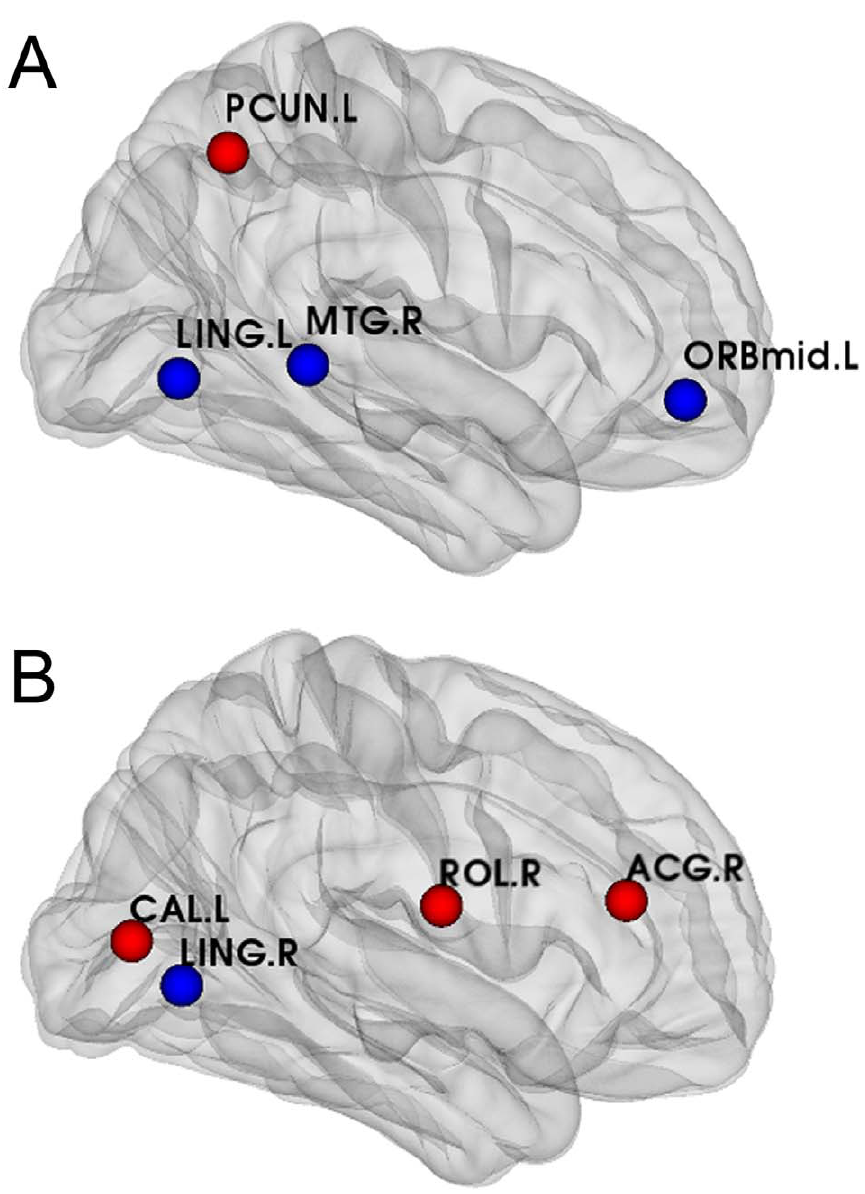
Figure 5. Abnormal changes in between-group nodal centrality in the MCI and AD groups. Each of the eight regions belongs to the hub regions in at least one of the three cortical networks and showed a significant difference (p , 0.05). The blue spheres indicate significant decreases in between-group nodal centrality. The red spheres indicate significant increases in between-group nodal centrality. A - Abnormal changes shared by the MCI and AD groups. B - Abnormal changes only in the AD group. Note that no abnormal changes occurred only in the MCI group. For the abbreviations of the regions, see Table 2.